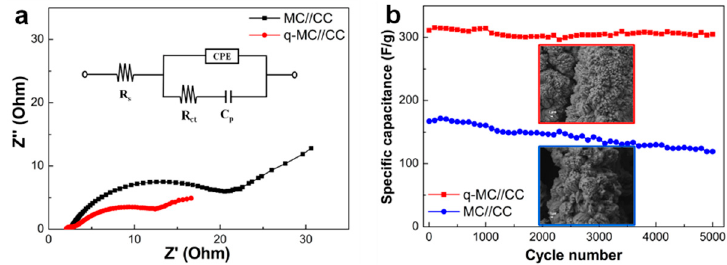
Figure 5. ( a ) Nyquist plots and ( b ) Cycling test of q-MC // CC and MC // CC along 5000 cycles at the scan rate of 50 mV · s − 1 (insets show their SEM images after cycle test).